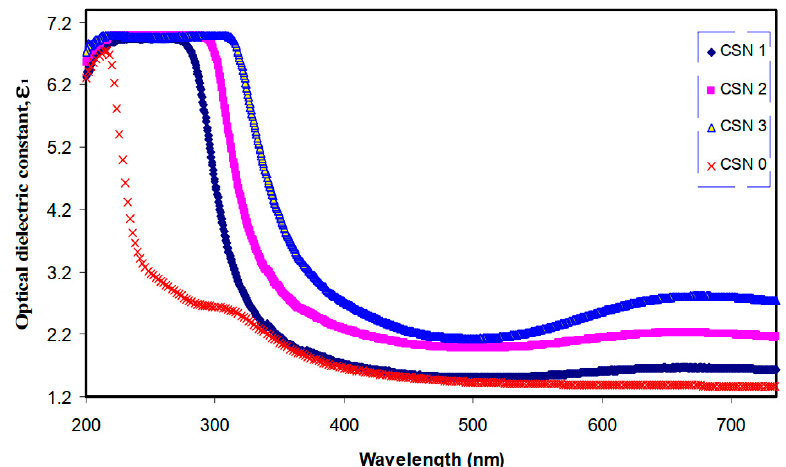
Figure 27. Optical dielectric constant spectra against wavelength for pure CS and doped CS films. The chitosan nanocomposite (CSN) films were symbolized as CSN0, CSN1, CSN2 and CSN3 for CS doped with 0 wt %, 4 wt %, 8 wt % and 12 wt % CuI, correspondingly [78].